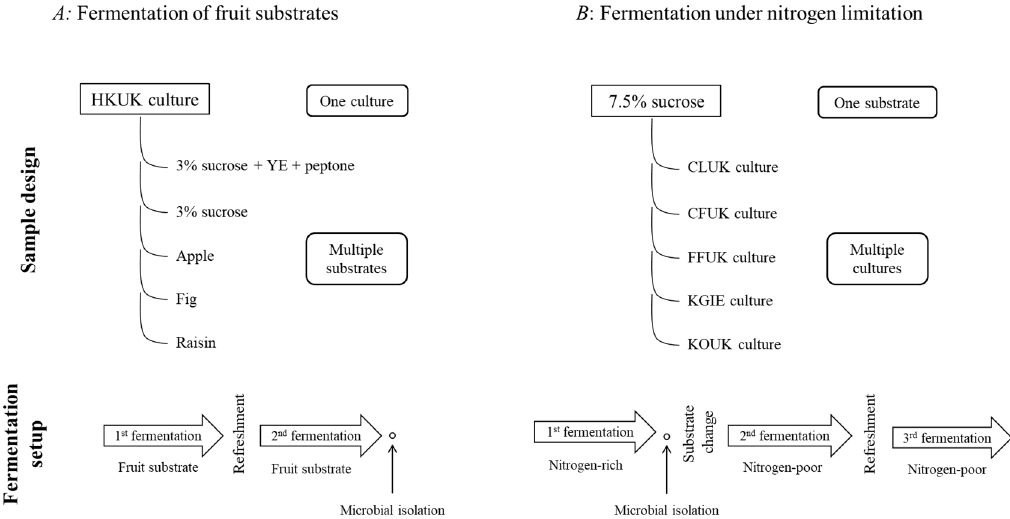
Figure 1. Experimental design. ( A ) Fermentation of fruit substrates. ( B ) Fermentation under nitrogen limitation.